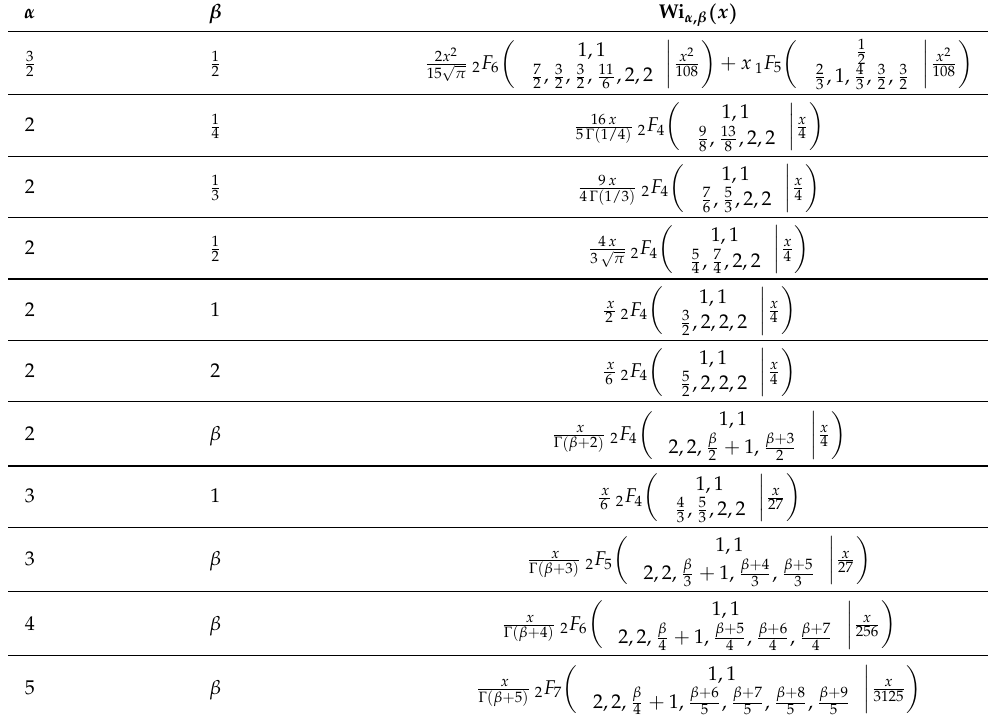
Table 11. The integral Wright functions Wi α , β derived for some values of parameters α and β by using